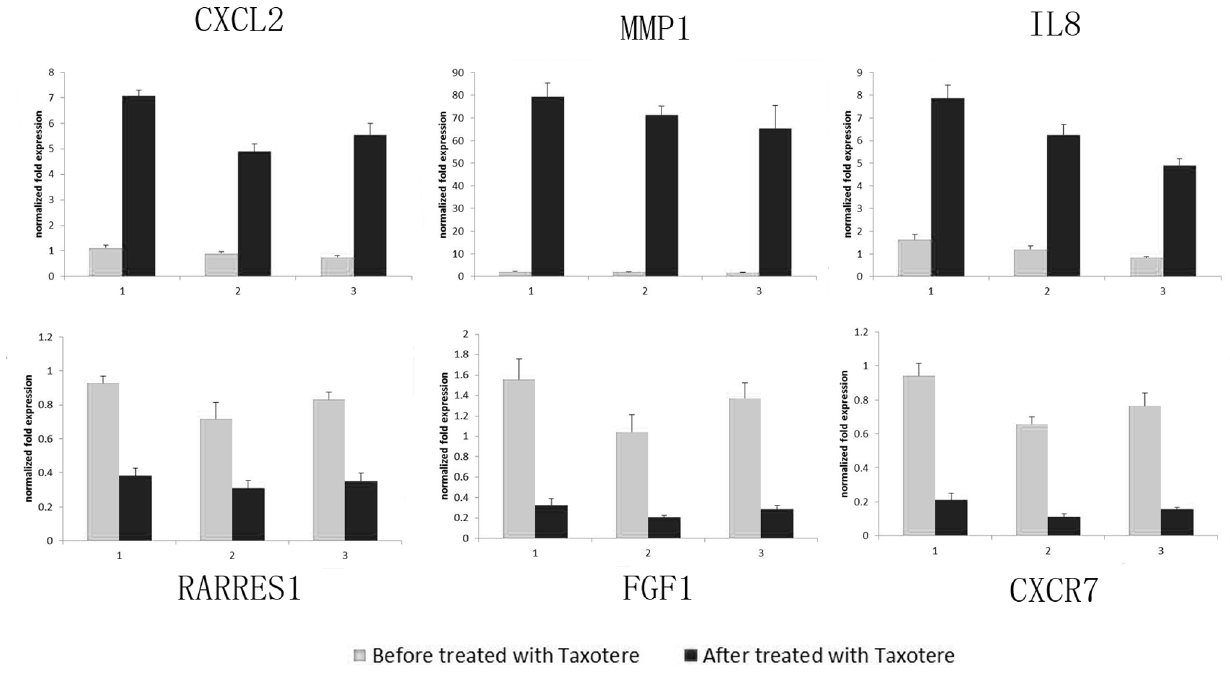
Figure 4. Differential expression of candidate genes in CAFs before and after chemotherapy. The candidate genes were picked up from 35 differential genes, including up-regulated genes CXCL2, MMP1, IL8, as well as down-regulated genes RARRES1, FGF1, and CXCR7. The differential expression of 6 genes in three pairs of CAFs before and after chemotherapy (treated with 20 ng/ml Taxotere) was confirmed by Real-Time PCR. It was found that there was significant difference between the expression of 6 candidate genes in CAFs before chemotherapy and after chemotherapy ( p , 0.05).